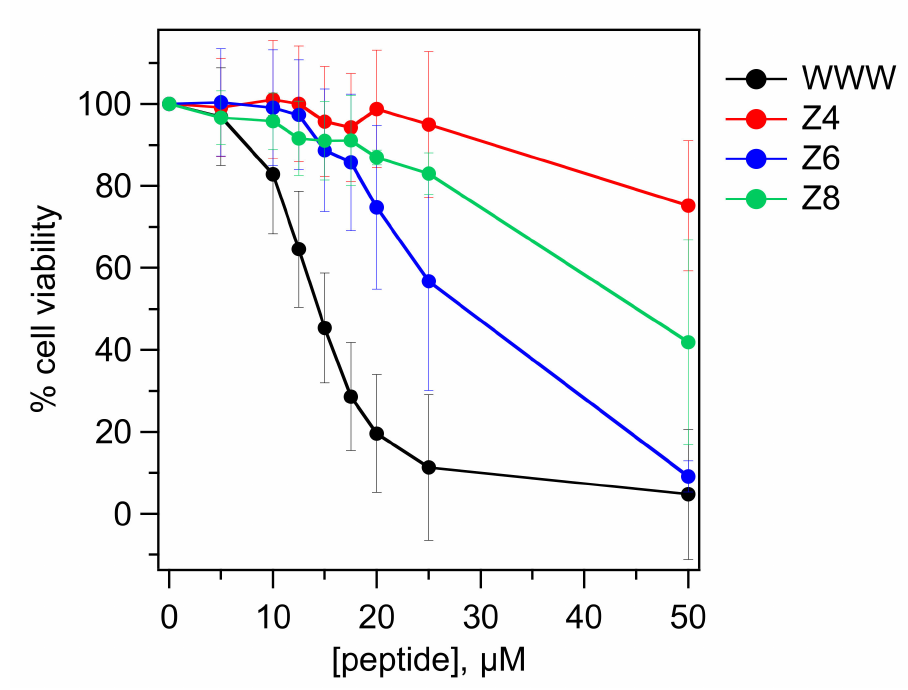
Figure 7. Cytocompatibility of 3T3 mouse fibroblast cells as measured by resazurin